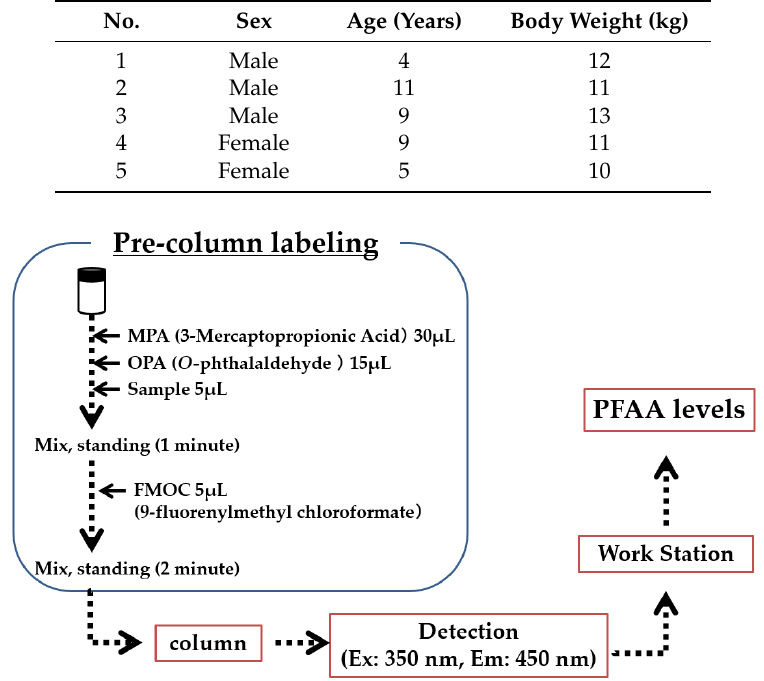
Figure 1. The schema of pre-column labeling method.